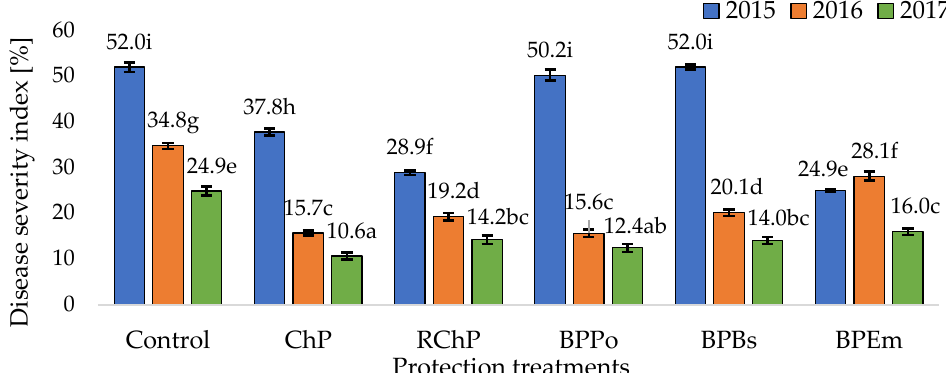
Figure 1. Infection of horseradish roots by a fungi complex causing Verticillium wilt. Disease severity index (DSI) [%] (homogeneous groups, Tukey’s HSD test, α = 0.05). Values marked with the same letters do not differ statistically significantly, p < 0.05. Control—Without protection; ChP—Chemical protection; RChP—Reduced chemical